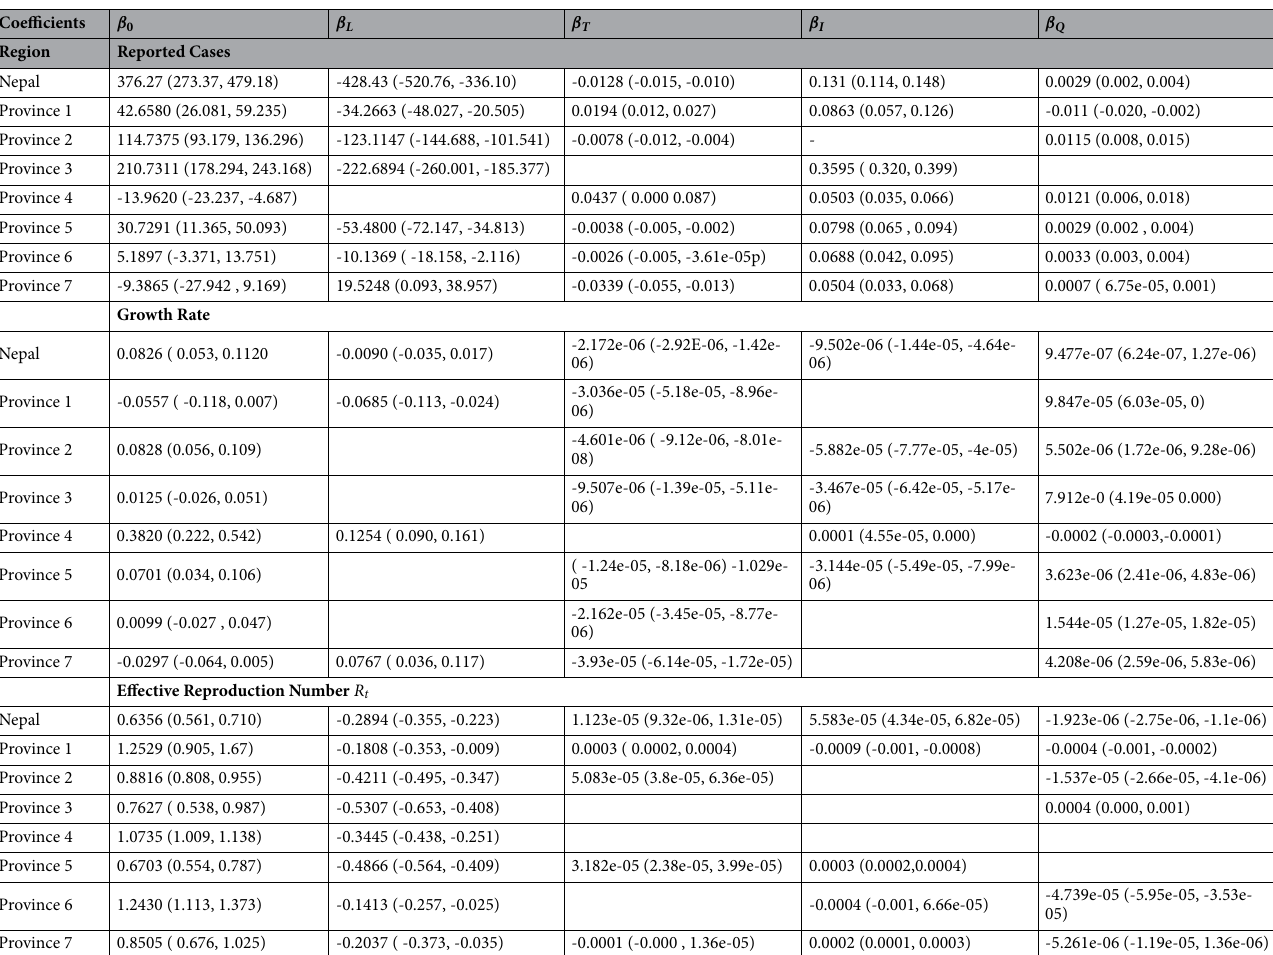
Table 4. Regression Coefficients of the best model for the reported cases, the daily growth rate and the effective reproduction number, R t , in Nepal and its